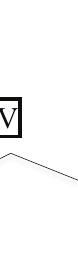
FIGURE 2 | Bengalese finch